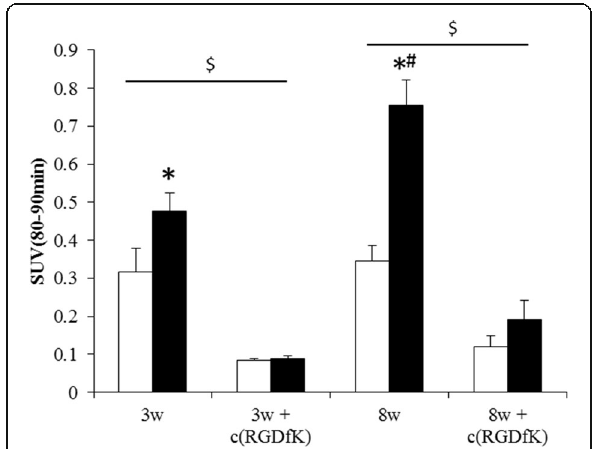
Fig. 5 Hepatic SUV at 80 – 90 min. Data are expressed as the mean ± SD ( n = 5 per group or n = 3 per group (+cRGDfK)). Statistical differences were assessed using Steel-Dwass test; * p < 0.05, compared with respective control mice, # p < 0.05 compared with mice fed the CDAHFD for 3 weeks and Wilcoxon test, $ p < 0.05 compared with respective blockade group. White bar, control group; black bar, CDAHFD group